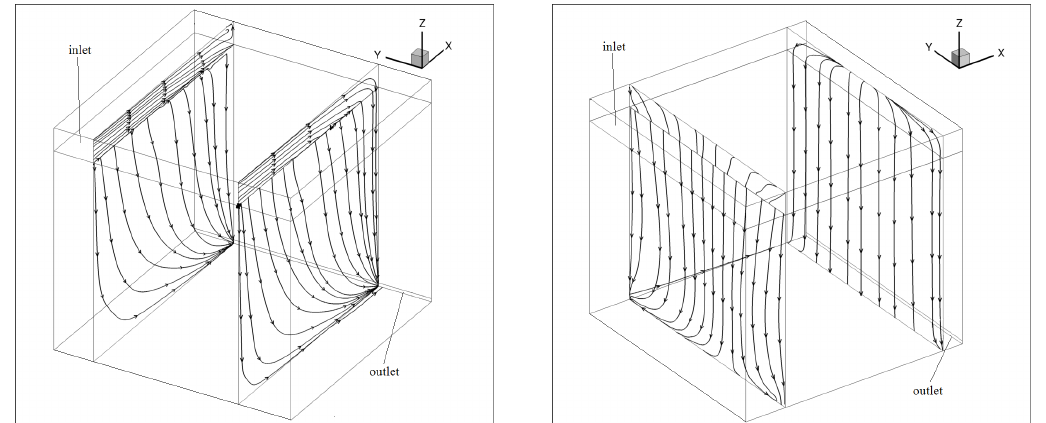
Figure 13. Streamlines for the continuous distribution and the Outlet 2 configuration.